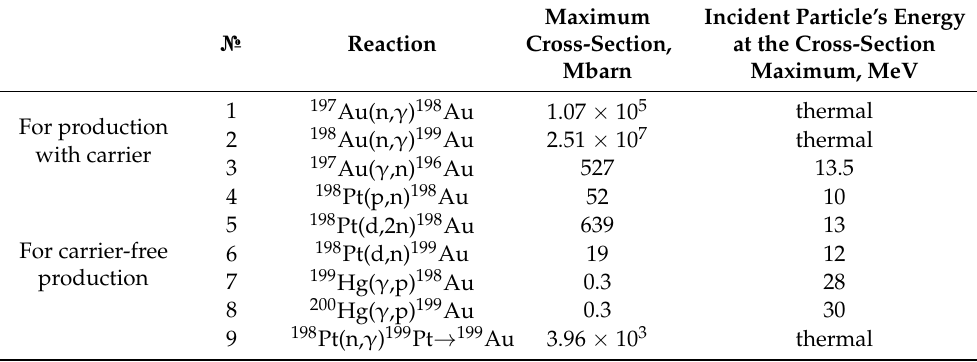
Table 3. Cross-sections of nuclear reactions leading to the formation of Au isotopes according to TENDL2021 database